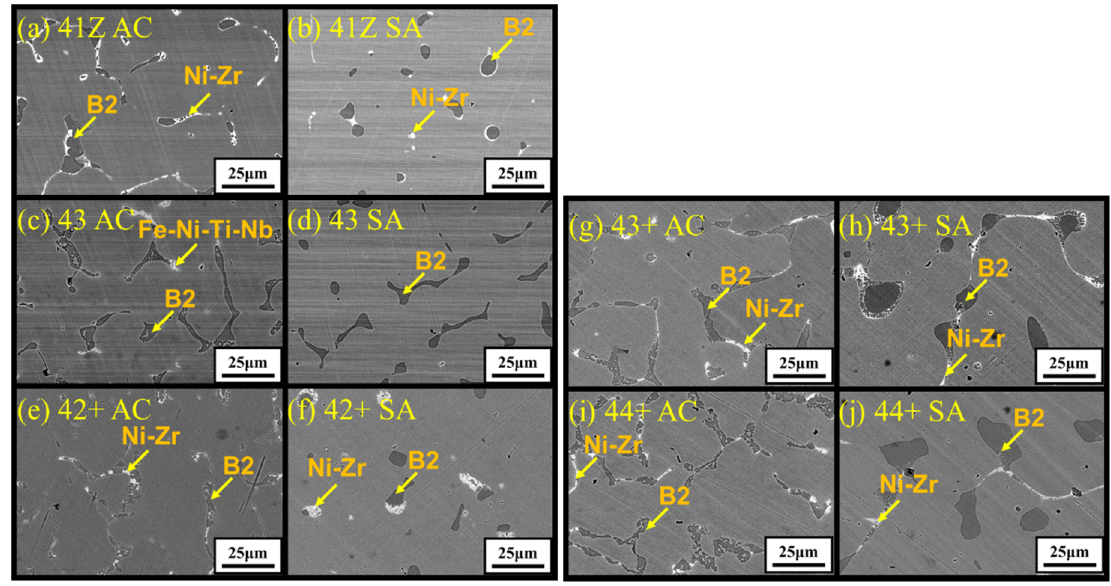
Figure 2. SEM-BSE images showing the microstructure of the developed alloys ( a ) 41Z AC, ( b ) 41Z SA, ( c ) 43 AC, ( d ) 43 SA, ( e ) 42+ AC, ( f ) 42+ SA, ( g ) 43+ AC, ( h ) 43+ SA, ( i ) 44+ AC, and ( j ) 44+ SA. ID B2 = Interdendritic B2-NiAl phase. Table 2. Average composition in at% from SEM-EDS analysis for interdendritic phases in alloy 43+ in as-cast (AC) and solution annealed (SA) conditions.